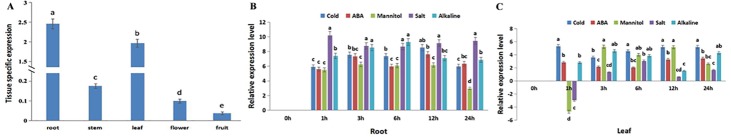
Quantitative reverse transcription-PCR (qRT-PCR) analysis of MsWRKY11 expression patterns in Medicago sativa.(A) Tissue-specific expression of MsWRKY11 in root, stem, leaf, flower, and fruit tissues. (B, C) The expression pattern of MsWRKY11 in the root and leaf under abiotic stresses: salinity (300 mM NaCl); alkalinity (0.1 M alkaline solution of Na2CO3 and NaHCO3 in a 1:2 ratio); abscisic acid (ABA; 15 μM); drought (simulated with 150 mM mannitol); and cold (−4°C) for 1, 3, 6, 12, and 24 h. qRT-PCR was performed in triplicate to confirm the accuracy of the results. All of the relative expression levels were log2-transformed.